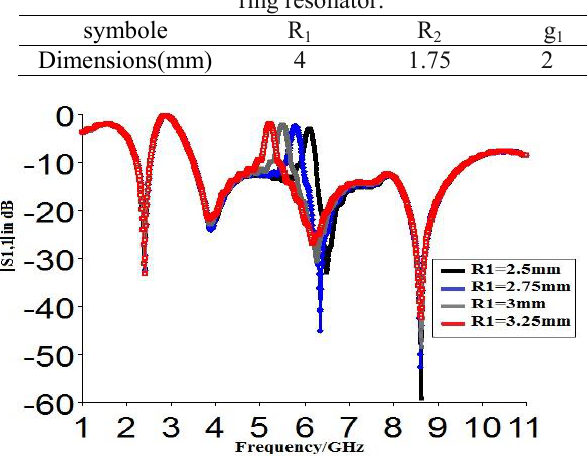
Figure 9: Simulated reflection coefficient for different R 1